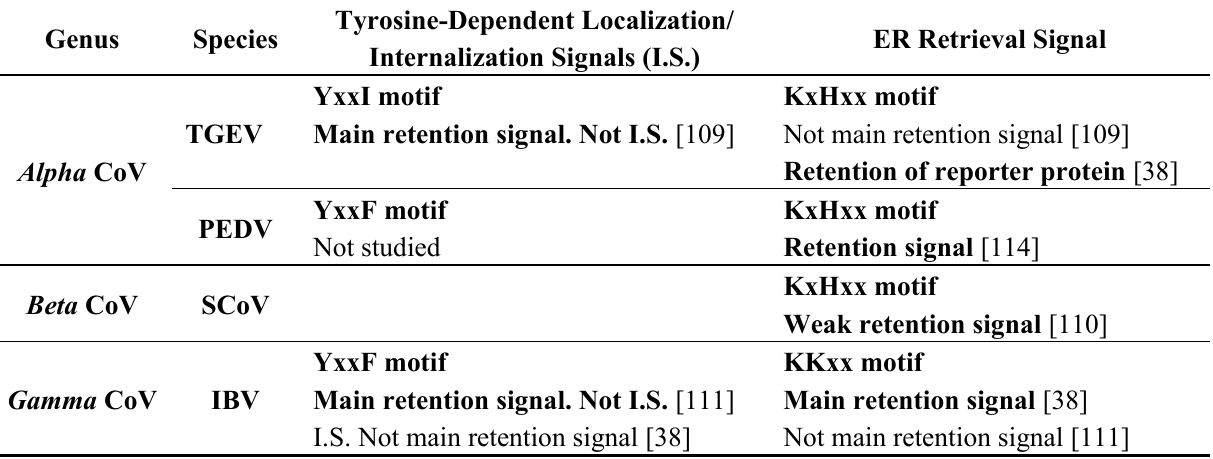
Table 2. Summary of the roles of the retention signals of several CoV-S